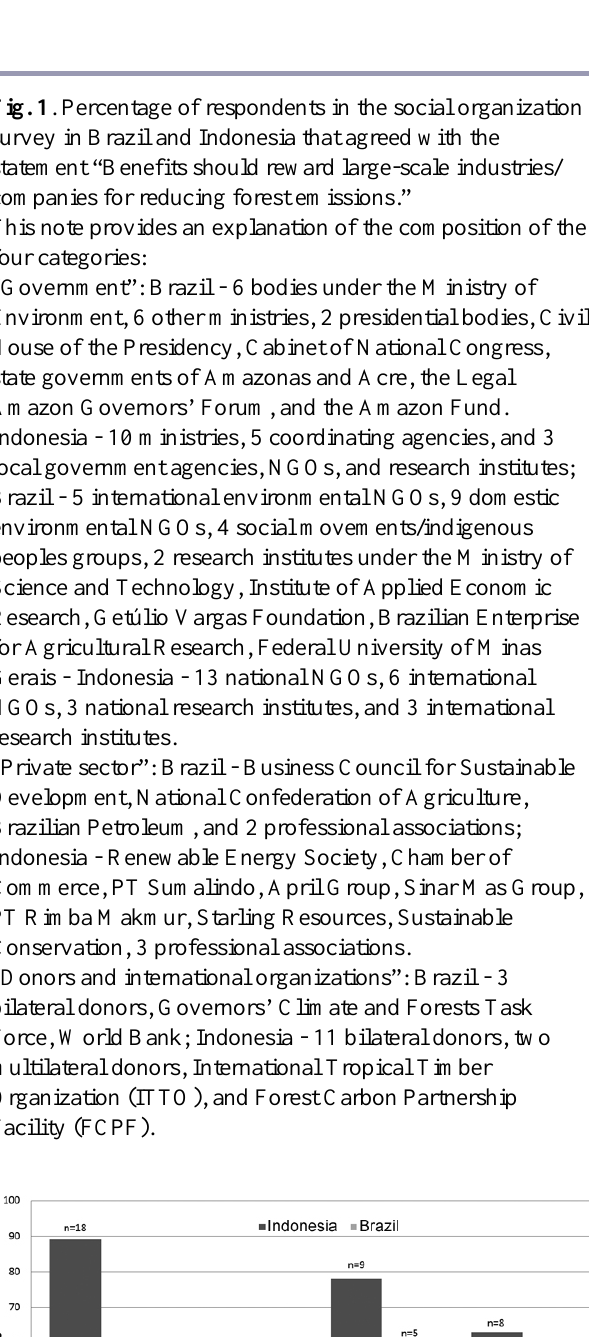
Fig. 1 . Percentage of respondents in the social organization survey in Brazil and Indonesia that agreed with